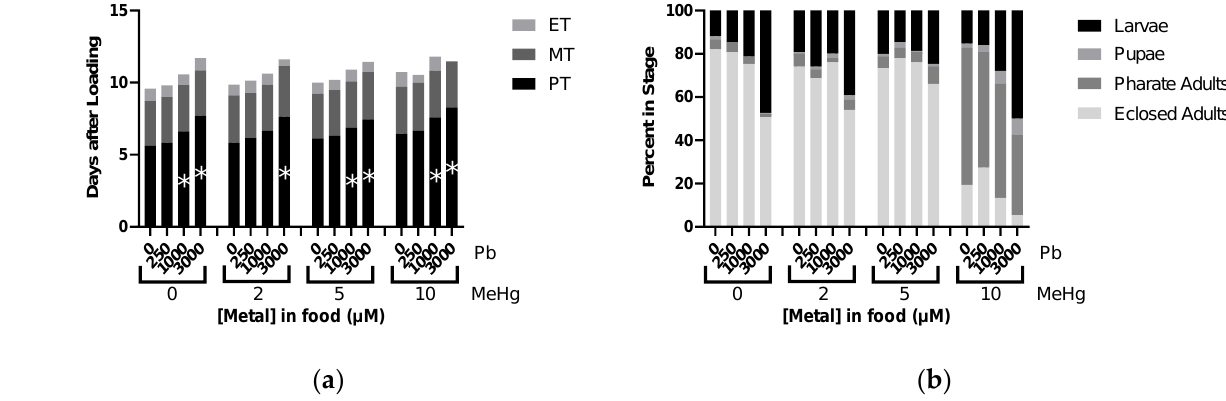
Figure 8. Effects of MeHg and Pb mixtures on Developmental Time Course. All data from same experiment using CS larvae dosed with indicated concentrations of MeHg and Pb in food. ( a ) Developmental Timing: average time spent in each stage across different treatment conditions. ( b ) Developmental Endpoints: average of individuals remaining in each stage of development at endpoint of 16 days. (* p < 0.05 compared to fixed value of MeHg at 0 µM Pb, two-way ANOVA)